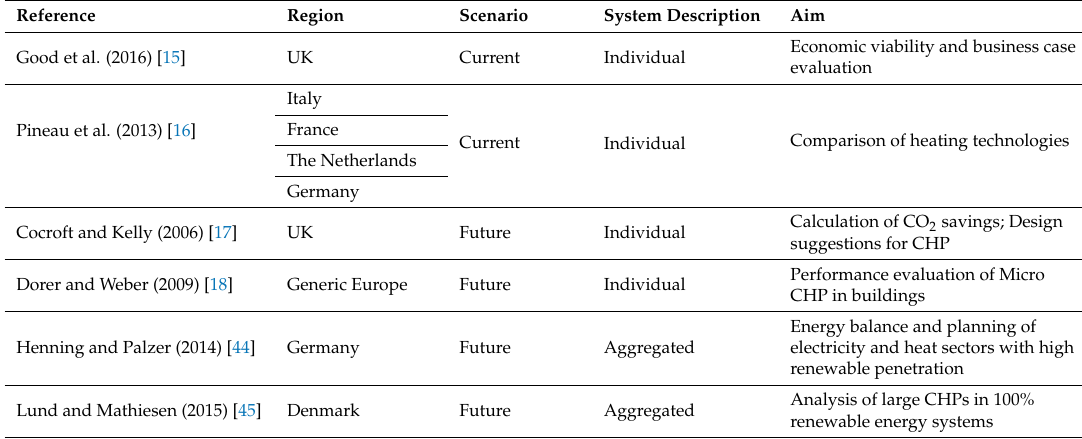
Table 1. Comparisons of heating technologies in the existing